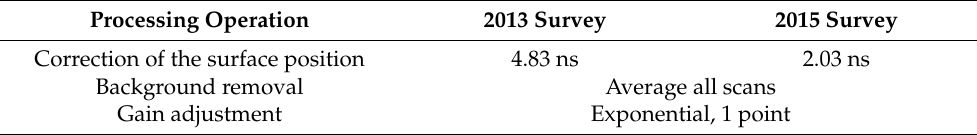
Table 2. Processing parameters of the GPR datasets performed in the GSSI RADAN 6.5